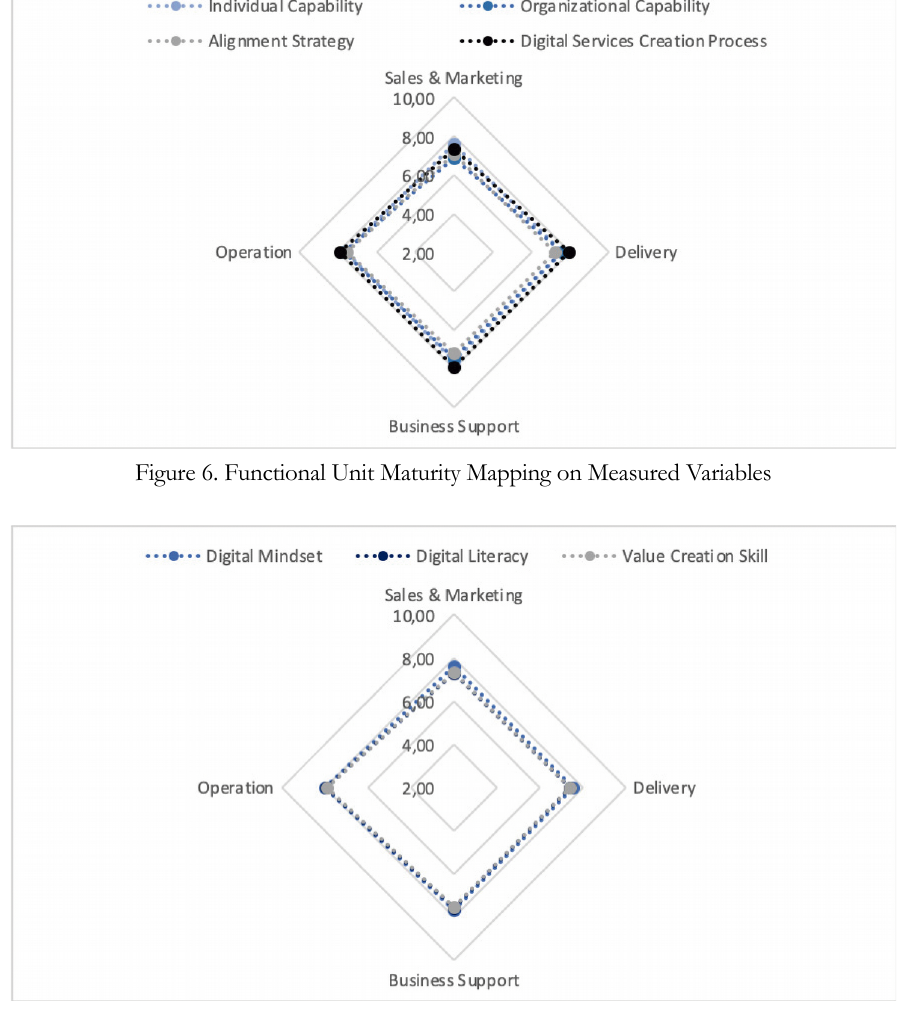
Figure 7. Functional Unit Maturity Mapping on Individual